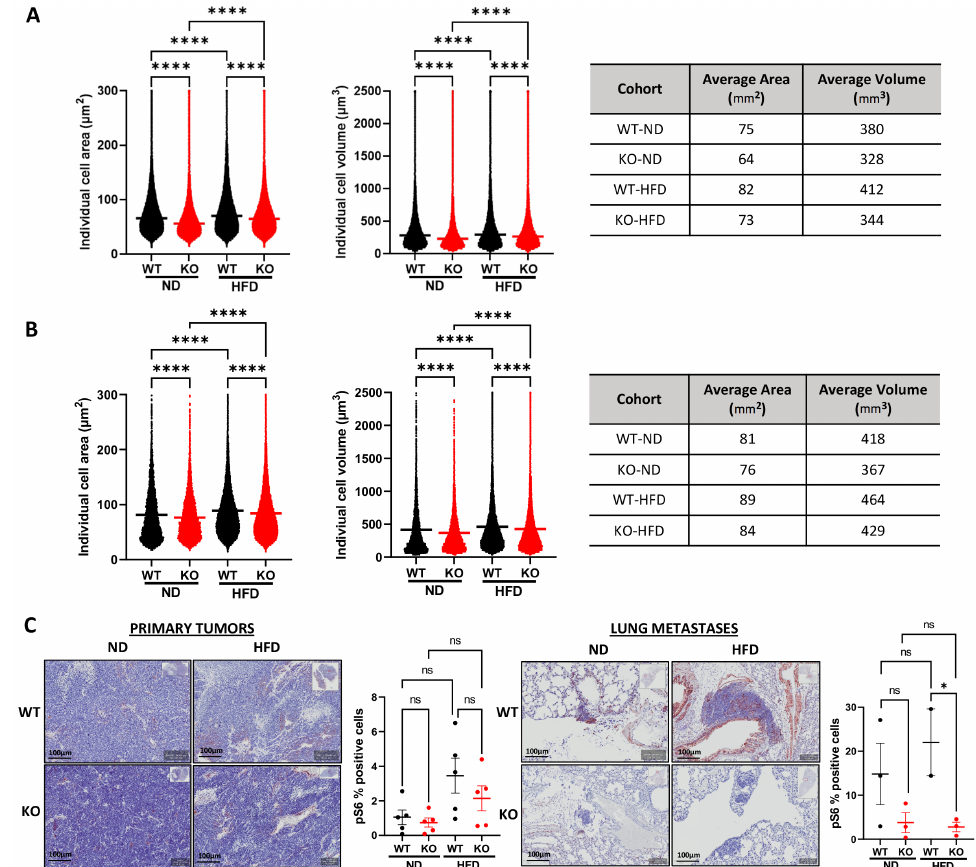
Figure 5. Host Camkk2 ablation decreased cancer cell size and mTOR signaling in TRAMP mice. ( A ) Individual cell areas and predicted cell volumes for primary tumors derived from 30-week old TRAMP; Camkk2 +/+ and TRAMP; Camkk2 − / − mice described in Figure 4A. ( B ) Individual cell areas and predicted cell volumes for lung metastases derived from the same TRAMP; Camkk2 +/+ and TRAMP; Camkk2 − / − mice. ( C ) Representative images (left) and quantification (right) of p-S6 IHC stains ( n = 5/group) from tumors in ( A ) and lung metastases in ( B ). ns = not significant; * p < 0.05, **** p < 0.0001. For each morphometric analysis, n > 1 × 10 6